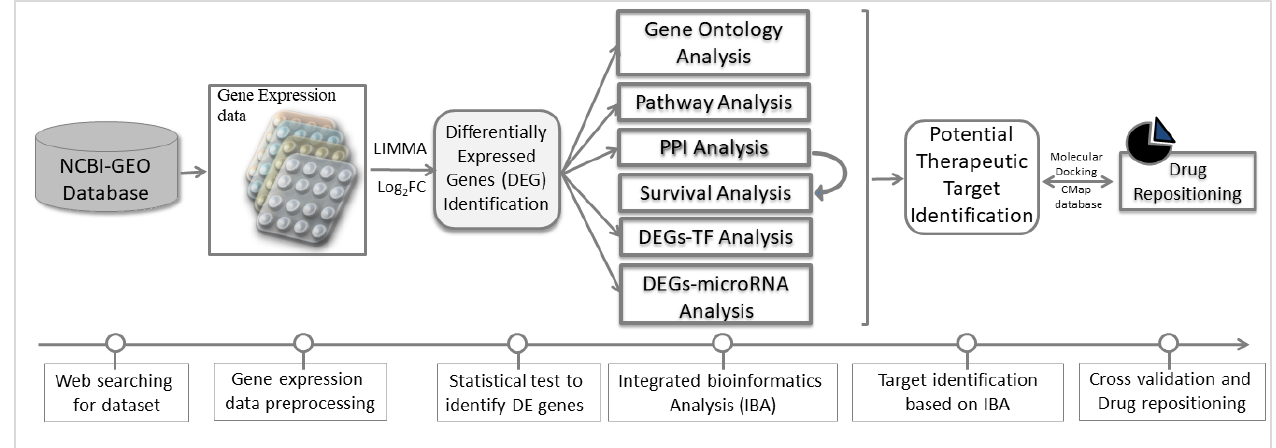
Figure 1. The schematic diagram of the integrative bioinformatics analysis of this study.